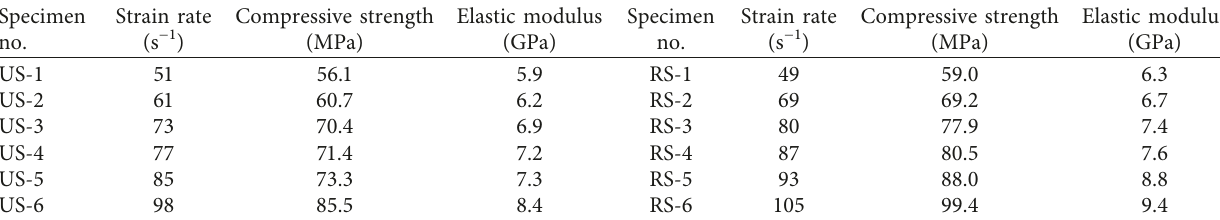
Figure 6: Stress-strain curves of samples under dynamic loading. (a) Unreinforced samples. (b) Reinforced samples. Table 1: The mechanical parameters of samples under dynamic